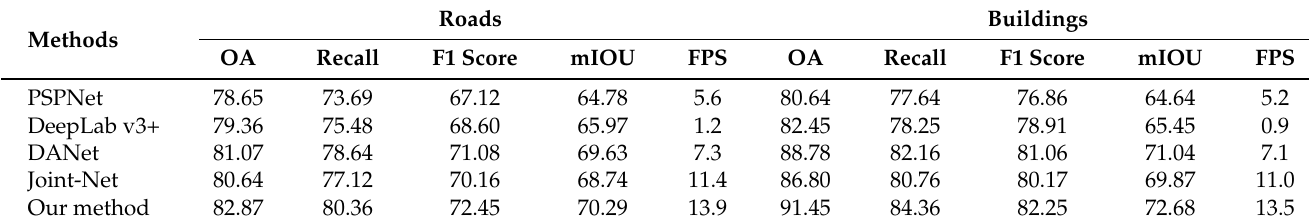
Table 4. Comparison of different networks on the Fuzhou testing dataset.